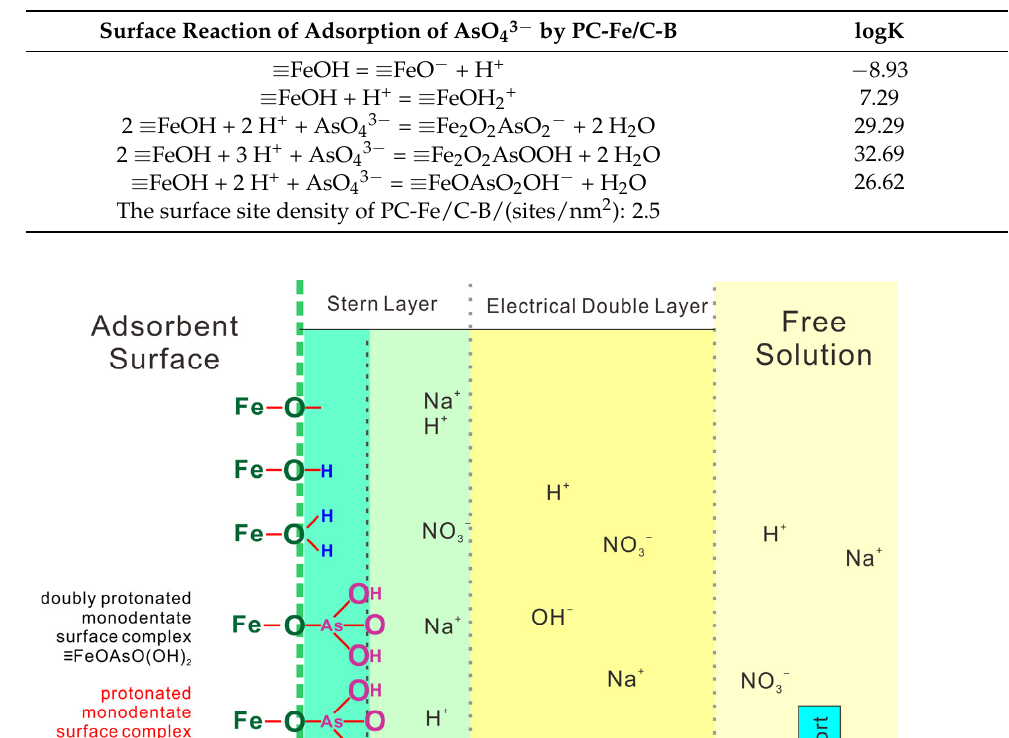
Table 2. Surface-complexation-equilibrium reactions of As(V) adsorption on PC-Fe/C-B, and the parameters used in CD-MUSIC model simulation.